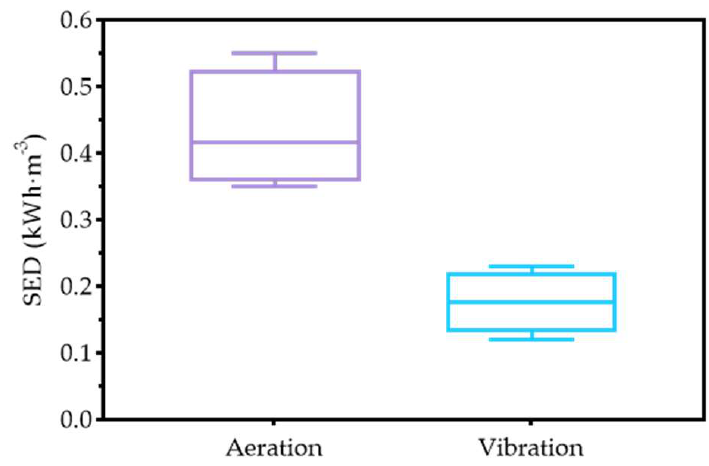
Figure 6. The different SEDs of aeration and vibration in an MBR.